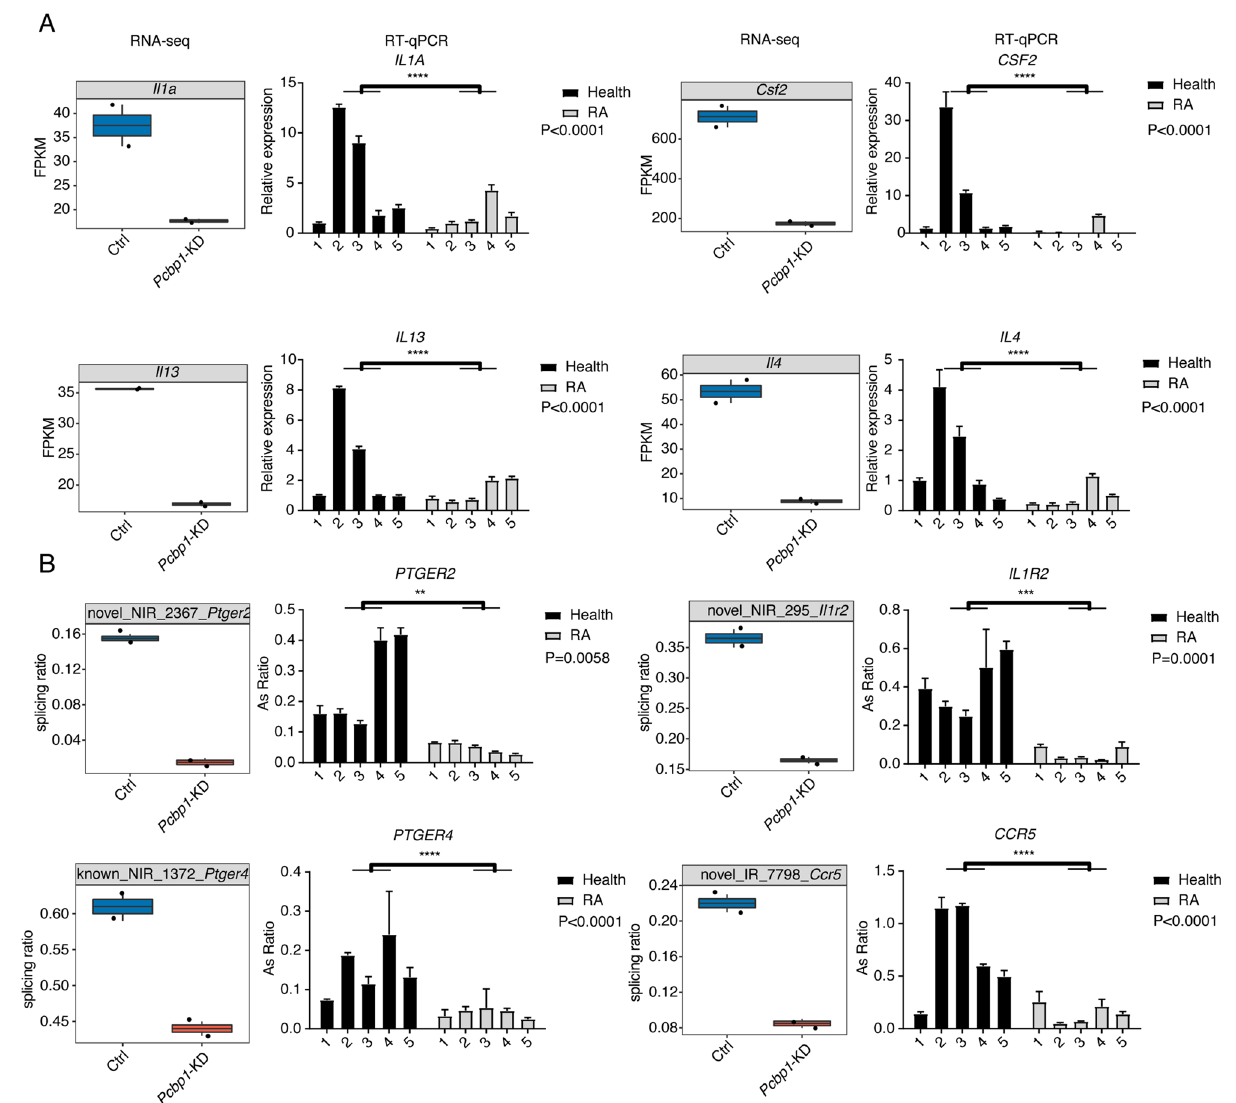
Figure 6. Experimental validation on DEGs RASGs by PCBP1 in PBMCs specimens from RA patients. ( A ) Bar plot showing the RT-qPCR validation results of immune and inflammation related DEGs regulated by PCBP1 in PBMCs from RA. Box plot in the left panel was expression level from RNA-seq in mice, and right panel was RT-qPCR result from RA patients. (**** P -value < 0.0001; two-ways ANOVA test). ( B ) Bar plot showing the RT-qPCR validation results of immune and inflammation related RASEs regulated by PCBP1 in PBMCs from RA. Box plot in the left panel was AS ratio from RNA-seq in mice, and right panel was RT-qPCR result from RA patients. (** P -value < 0.01; *** P -value < 0.001; **** P -value < 0.0001; two-ways ANOVA